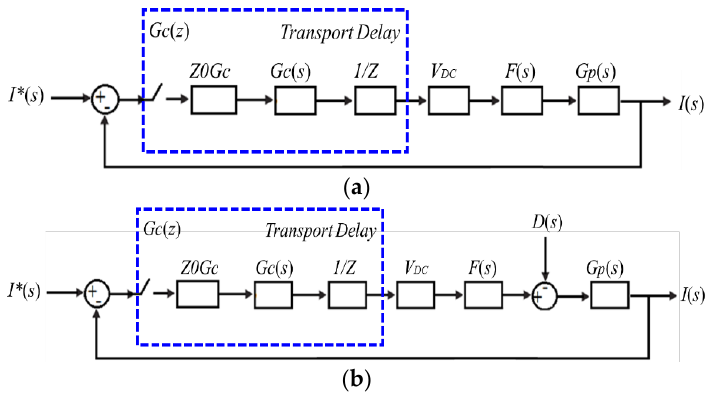
Figure 5. Average value diagram for the proposed system powering ( a ) RL load; and ( b ) motor load.